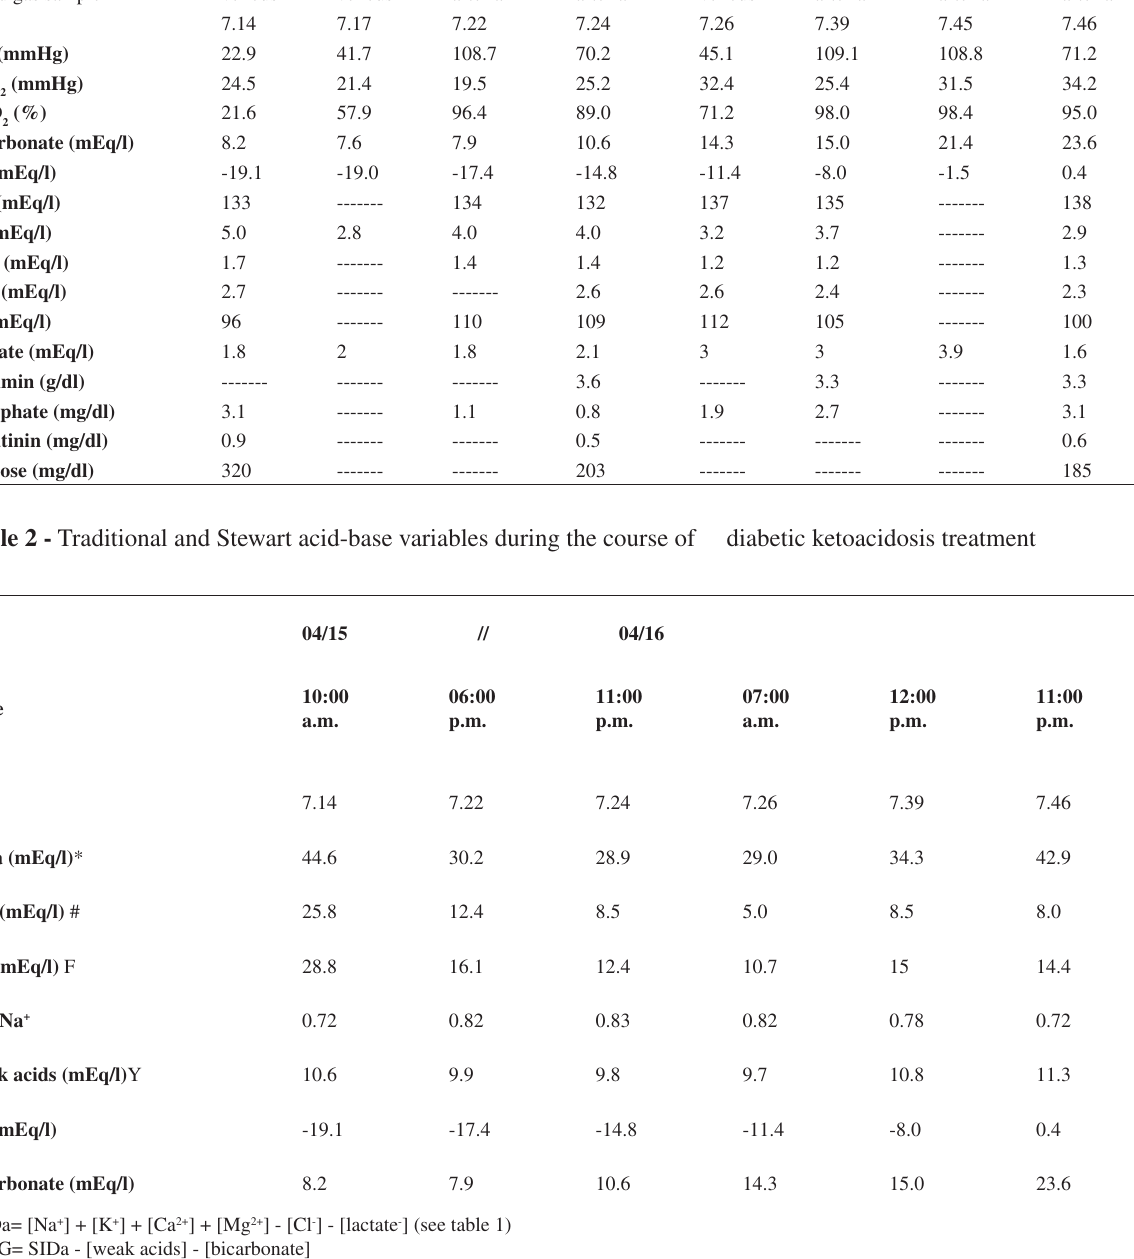
Table 1 - Biochemical and acid-base variables during the course of diabetic ketoacidosis treatment Day 04/15 // 04/16 Time